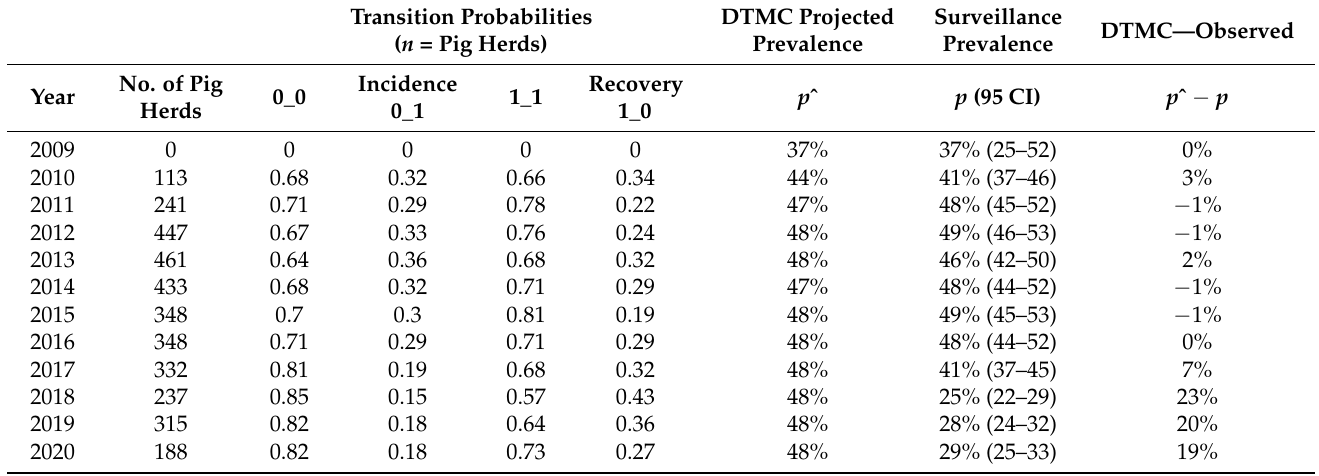
Table 2. Observed transition probabilities in surveillance data based on the incidence rates and recovery rates of pig herds that had consecutive years testing. The four transition probabilities were (a) negative herd remaining negative the following year (0_0), (b) negative herd turning positive the following year (0_1), (c) positive herd remaining positive following year (1_1) and (d) positive herd turning negative the following year (1_0). For the discrete-time Markov chain (DTMC) iterations, only the initial incidence rates and recovery rates derived from the 2009 to 2010 data became the fixed transition probability matrix. The last three columns of the table compare the observed prevalence ( p ) with the corresponding DTMC of projected herd prevalence ( pˆ ). To measure the congruence between the two prevalence, the last column ( pˆ − p ) shows the difference between observed p and pˆ